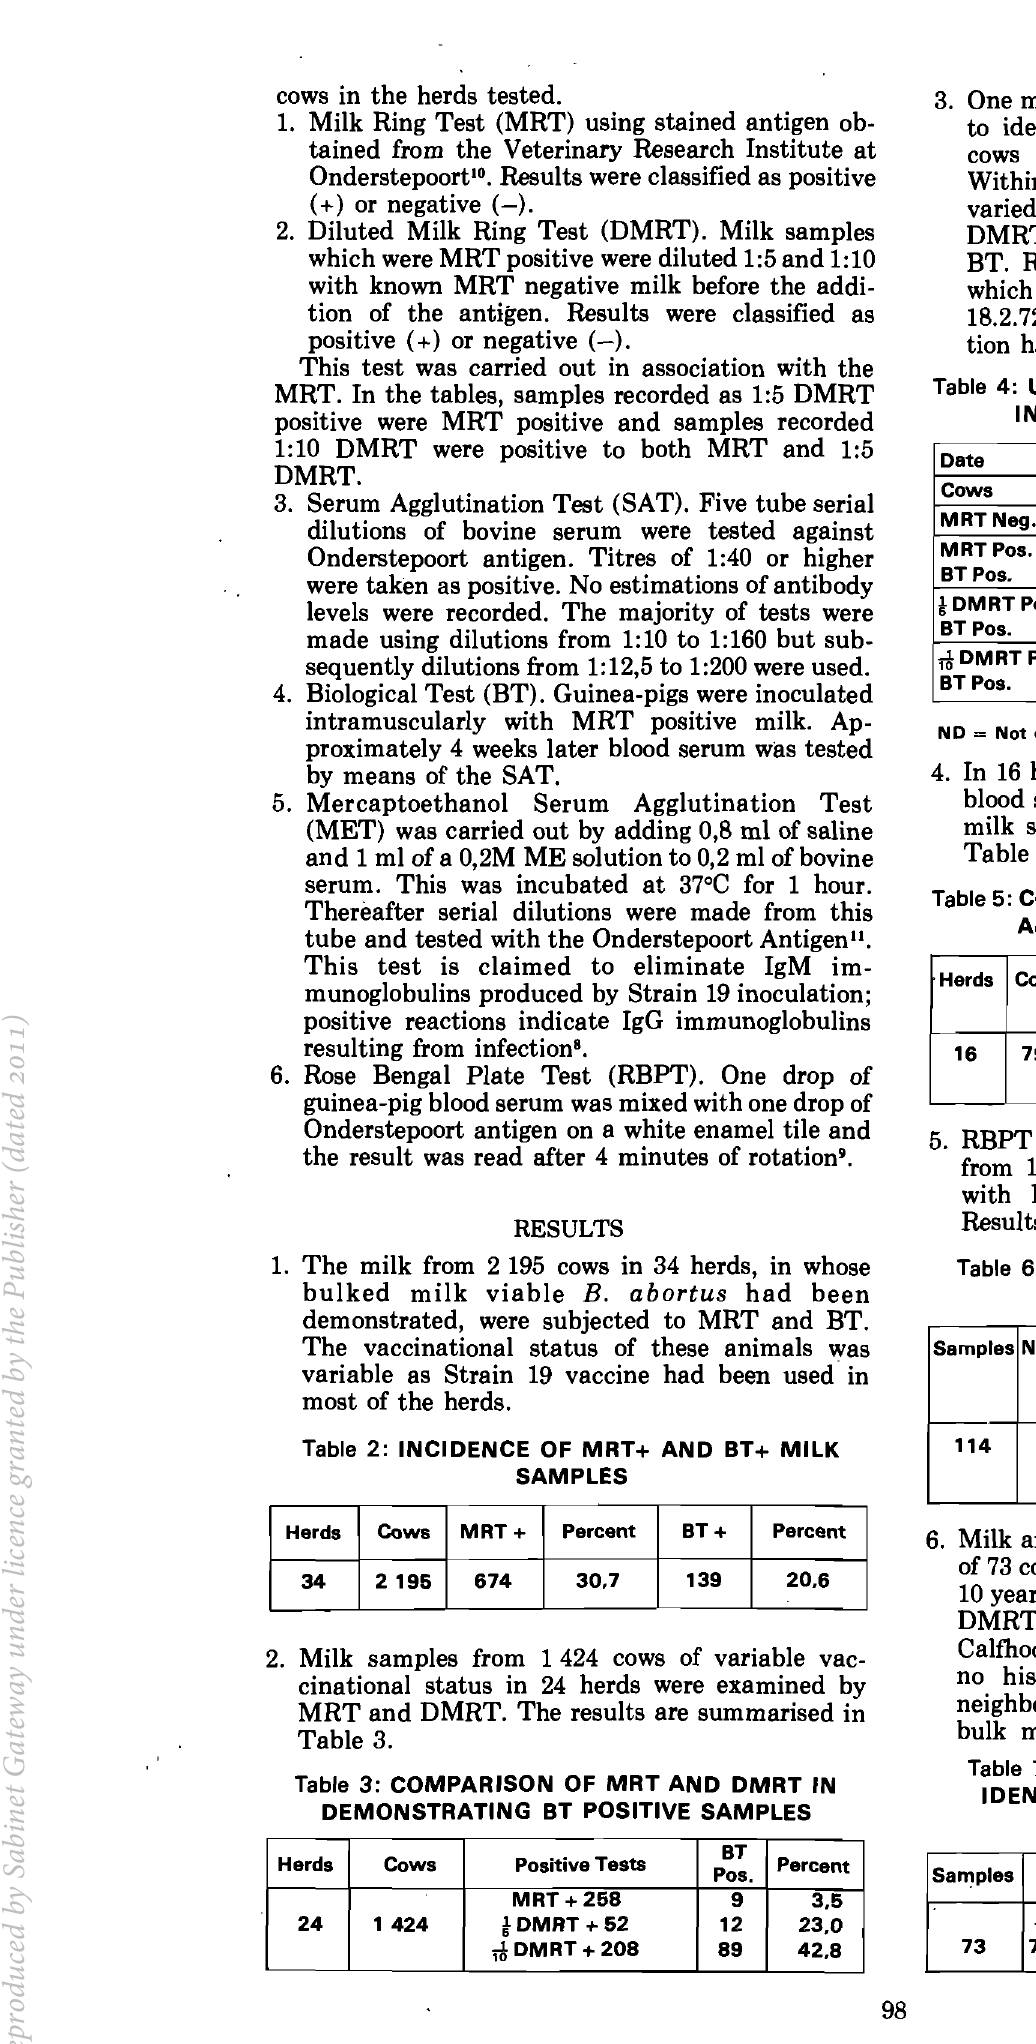
Table 3: COMPARISON OF MRT AND DMRT IN DEMONSTRATING BT POSITIVE SAMPLES Herds